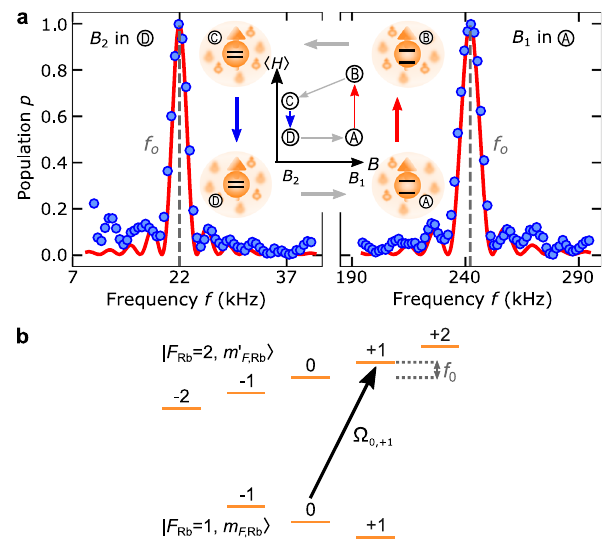
Fig. 4 Magnetic fi eld extraction. a Rb microwave spectra for extraction of the magnetic fi elds B 1 and B 2 . Center illustrates the engine cycle and the corresponding Zeeman energy splitting of a Rb bath atom. Red lines correspond to the theory curves and blue dots are experimental data. These measurements yielding magnetic fi elds B 1 = 346.5 ± 0.2 mG and B 2 = 31.6 ± 0.1 mG. Measured spectra con fi rm similar magnetic fi elds for B and C. b Corresponding microwave transition scheme in the Rb ground-state hyper fi ne